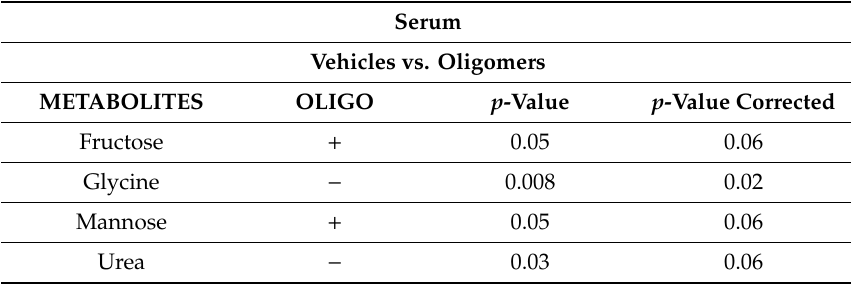
Table 3. Summary of the results of the univariate statistical analysis of the serum samples. Univariate statistical analysis of serum from rats treated with Vehicle or H α SynOs. + and - indicate respectively an increase or decrease of the metabolite in the OLIGO as compared with the Vehicle